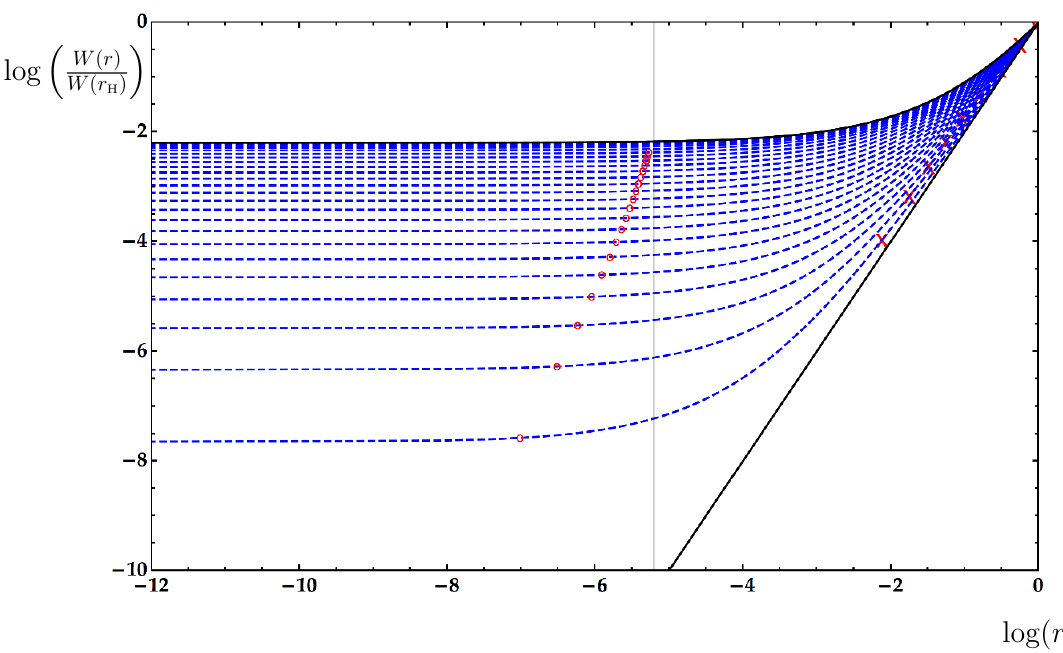
Figure 16 . The numerical solutions for the metric function W inside the horizon for values of =T 2 0, 0.68, 1.4, 2.1, 2.8, 3.6, 4.5, 5.4, 6.4, 7.5, 8.7, 10, 12, 14, 16, 19, 23, 28, 34, 43, 57, 78, 118, B (cid:25) 207, 534, are shown in dashed lines from top to bottom. For each solution W we indicated with a circle the place up to which, when moving away from the singularity, it remains constant up to one part in a hundred, and the vertical line indicates where the black brane solution fails to satisfy this condition. Whit an \x" we mark the evaluation of each function W at the r Cross obtained from its corresponding U in (cid:12)gure 15. The top solid line is the black brane solutions and the diagonal solid line on the right is the BTZ R 2 (cid:2)